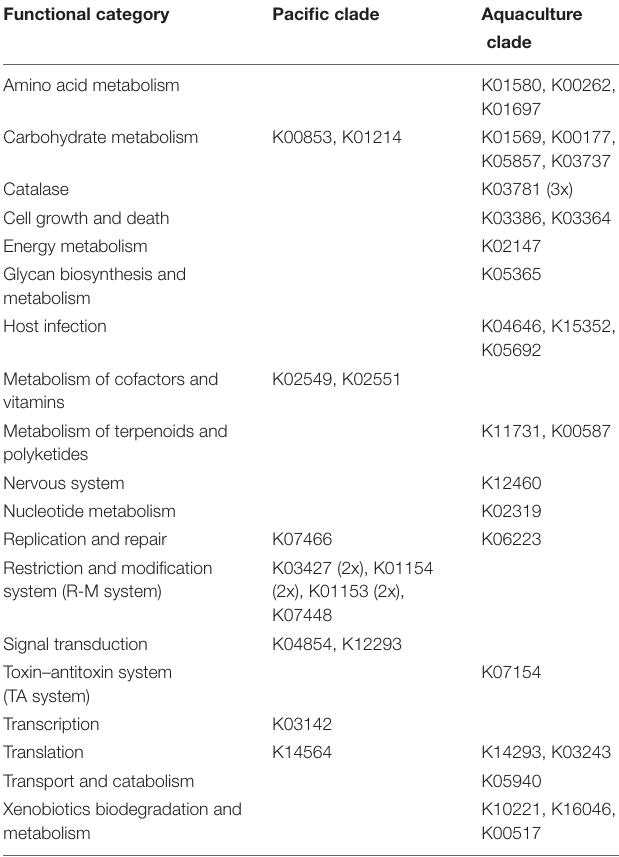
TABLE 4 | Specific functional orthologs of Phaeobacter gallaeciensis